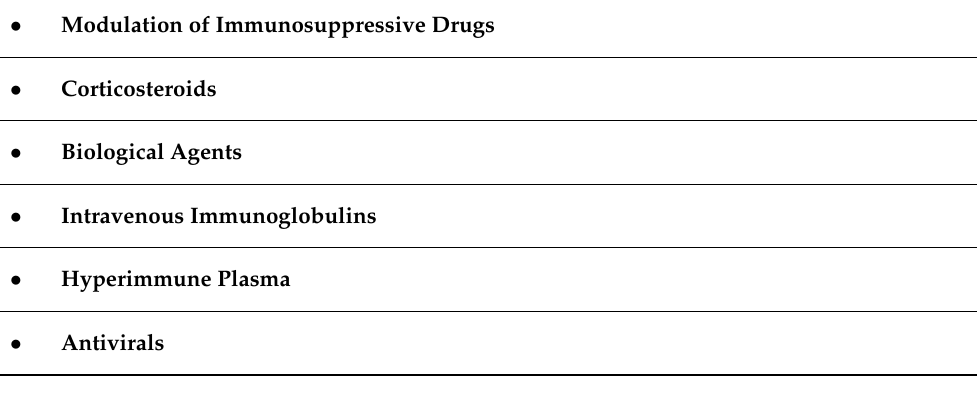
Table 3. Therapeutic strategies for COVID-19 kidney transplant